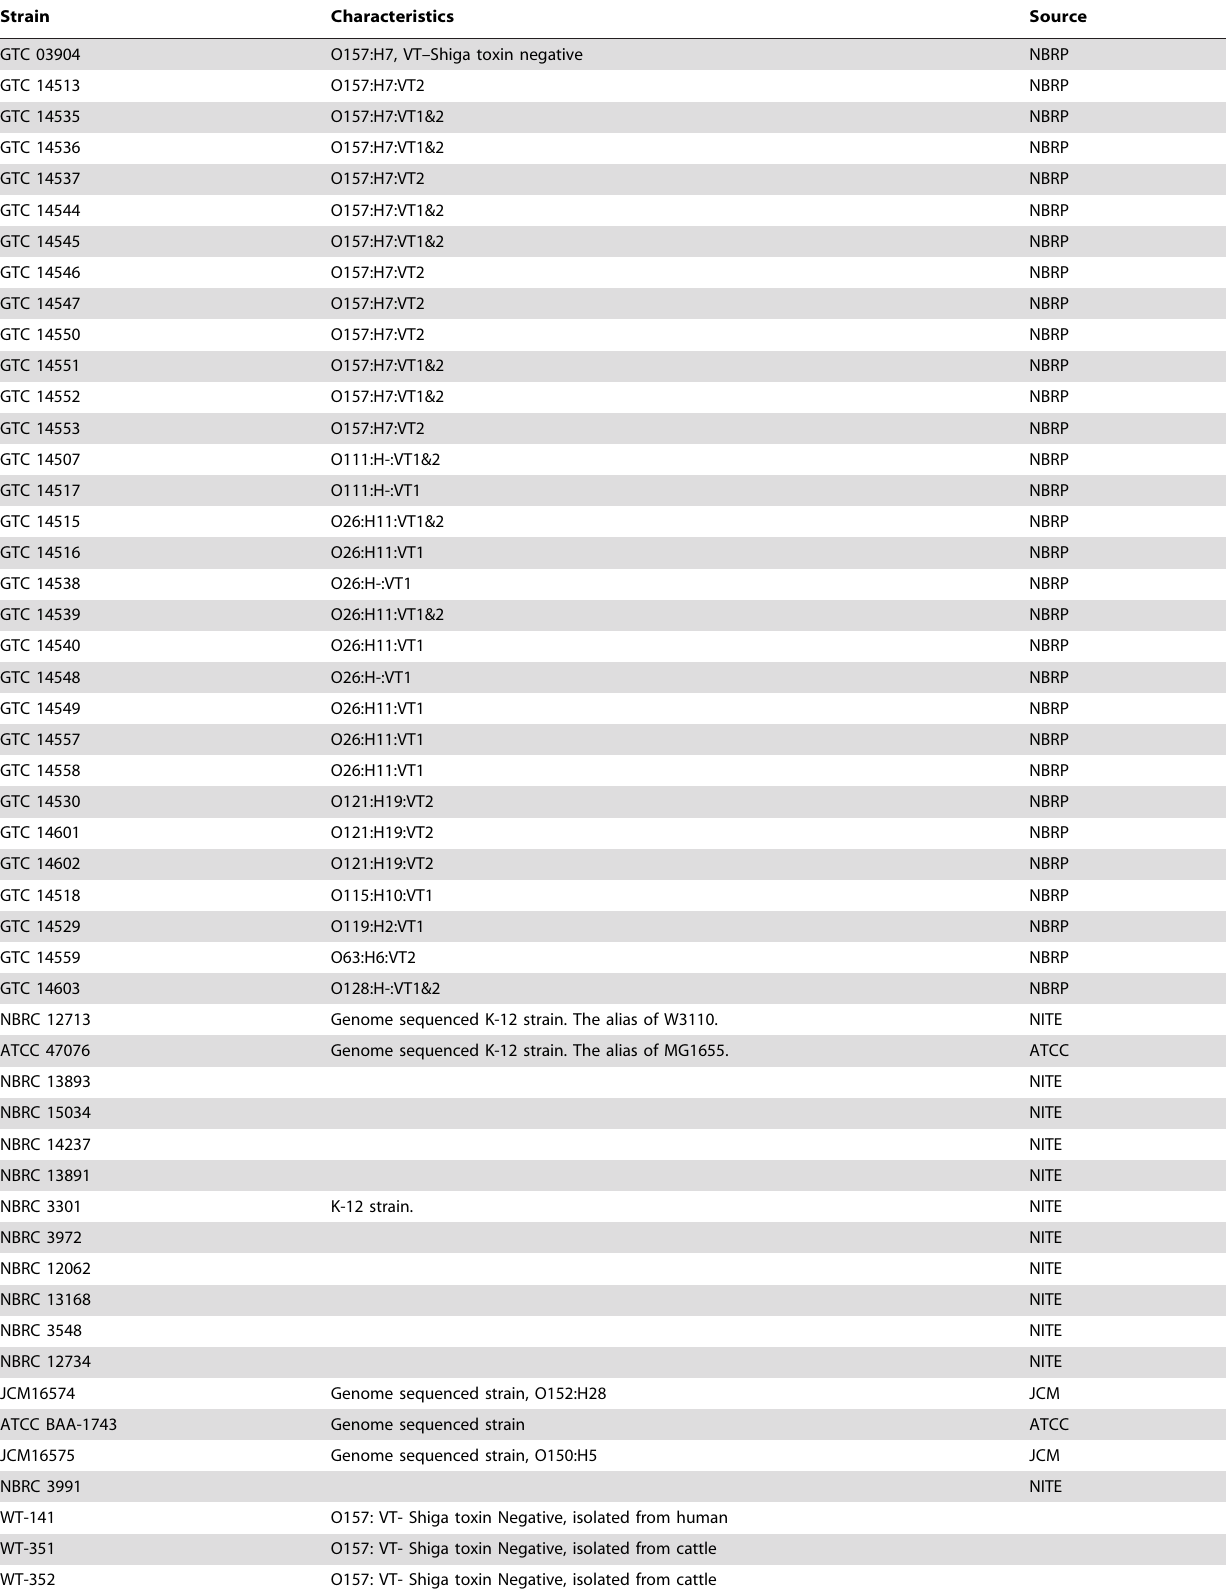
Strain Characteristics